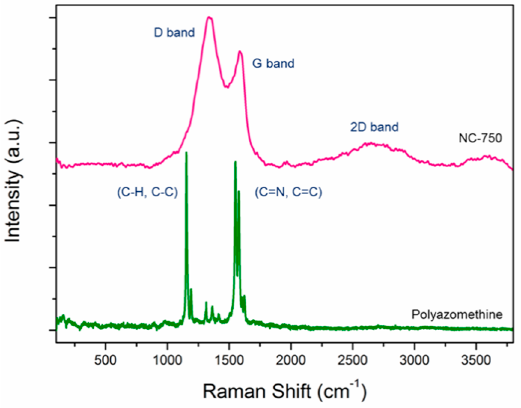
Figure 6. Raman spectra of PAM and